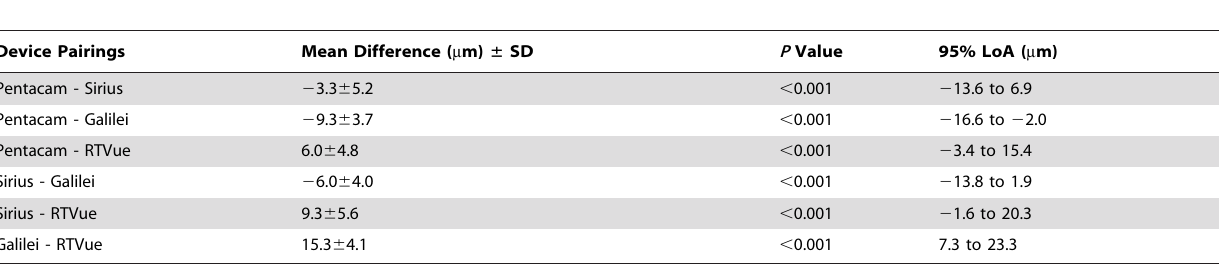
Table 2. Mean difference of central corneal thickness, corresponding results of Bonferroni post hoc comparison and 95% limits of agreement (LoA) among the 4 investigated devices.